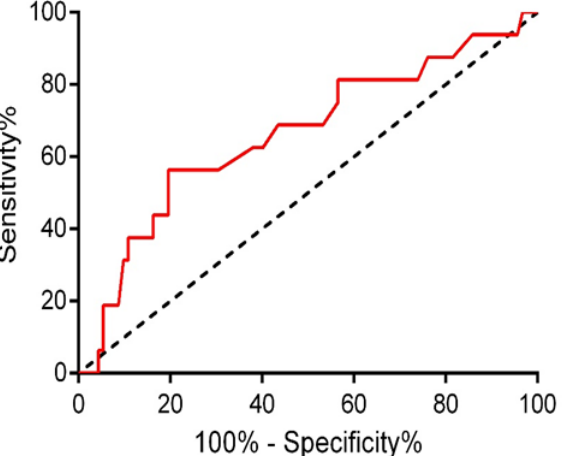
Figure 1. ROC curve analysis of post-operative lactate levels for the occurrence of severe complica- tions. The optimal cut-off value was 5.05 mmol/L, with an area under the curve of 0.661 ± 0.079 (95% CI 0.506–0.816), a sensitivity of 0.563, and a specificity of 0.804.